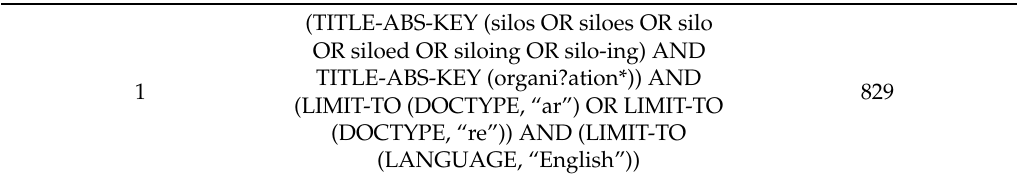
Complete search strategy on Web of Science (completed on 6 April